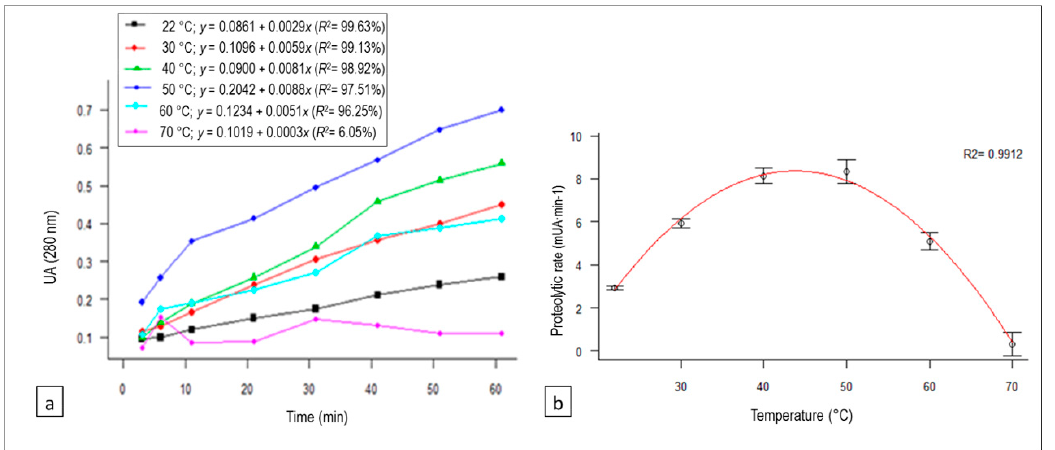
Figure 1. ( a ) Variation of absorbance (which correlates with proteolytic activity) with reaction time for each of the temperatures tested, as well as their regression equations and determination coe ffi cients ( R 2 ), for the proteolytic activity linear trend of the Cynara scolymus L. extract on bovine casein. ( b ) Quadratic regression model of the temperature e ff ect on the proteolysis rate of the C. scolymus L. extract on bovine casein.